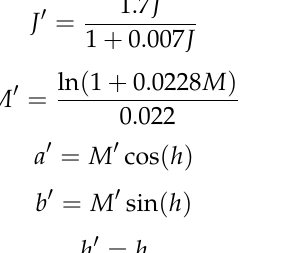
Figure 6. Schematic diagram of a computer vision system measuring device.